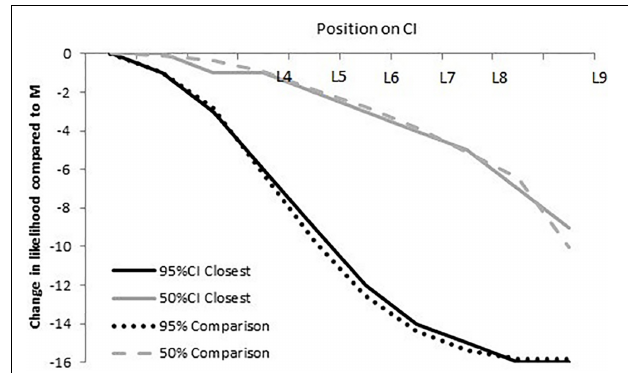
50% CI (upper dashed line) and a 95% CI (bottom dotted line). The solid curves illustrate the closest possible fit (with R 2 = 0.99) between a given response and its normative distribution (dotted or dashed curves), using the response scale used in our survey.